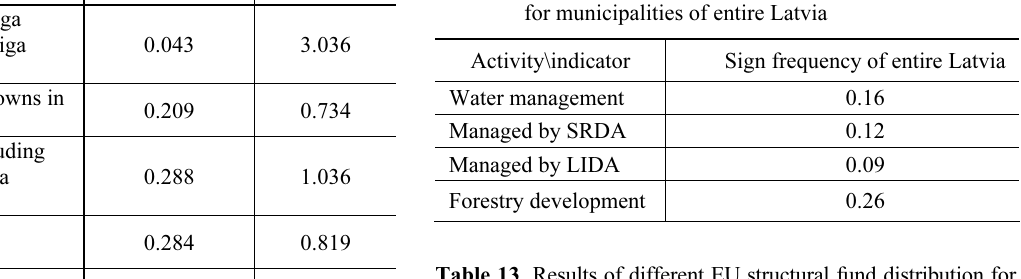
Table 12 . Results of different EU structural fund distribution